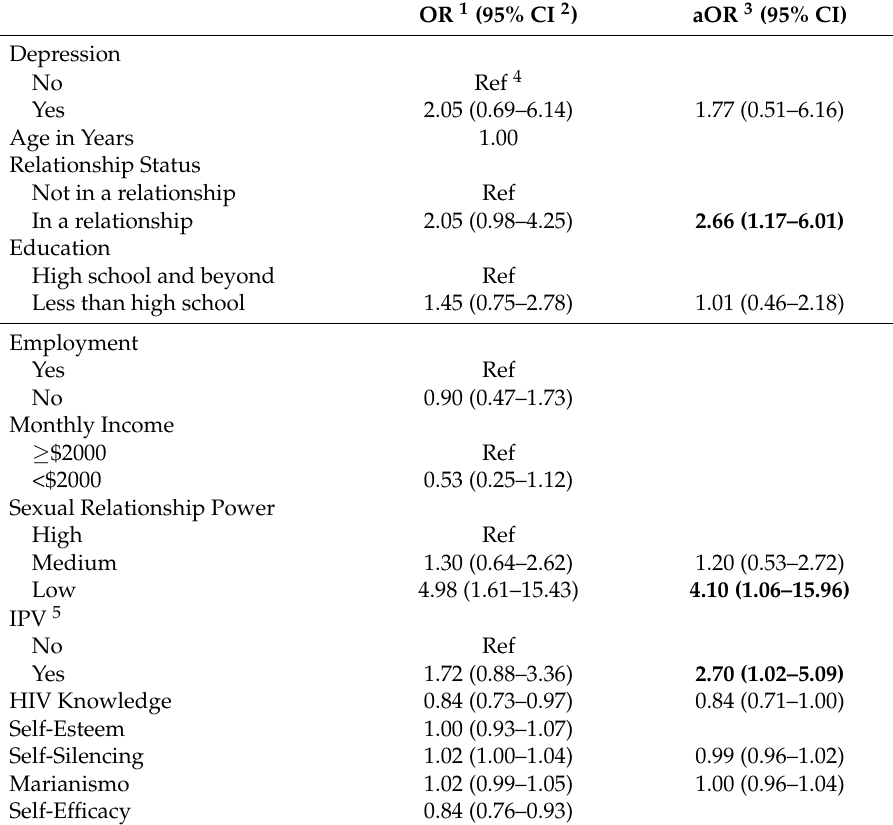
Table 3. Unadjusted and adjusted associations between depression and risky sexual behavior in adult Latina immigrant farm workers in the SEPA study in Miami-Dade County in Florida in